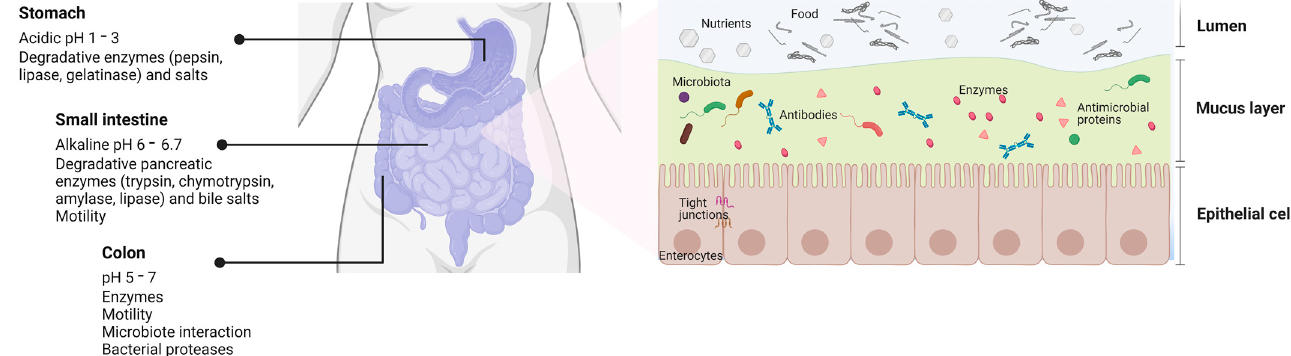
Figure 2. Scheme of the gastrointestinal tract and the physiological factors that influence the absorption of therapeutic molecules. Several physiological barriers in the gastrointestinal (GI) tract challenge drug administration by the oral route. In the GI environment, the presence of factors such as pH, degradative enzymes and salts, motility and interaction with the microbiota can alter the solubility and stability of drugs, which finally affect their permeability across the mucosal barriers. This figure is based on a schematic drawing and does not fully represent the accurate structural reality of the intestine (created with http://www.biorender.com (accessed on 21 november 2022)). The second mechanism described by which nanoparticles cross the intestinal layers and reach systemic circulation is transcellular transport by epithelial cells (mainly entero- cytes that constitute 90–95% of the cells in the GI tract) and M-cells (specialized phagocytic cells that represent 1% of the intestinal epithelium) [1]. Transcellular transport consists of